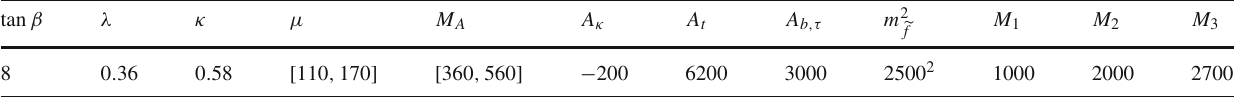
Table 4 Parameter values for the NMSSM scan with tan β = 8 for investigating a possible realization of the τ + τ − excess tan